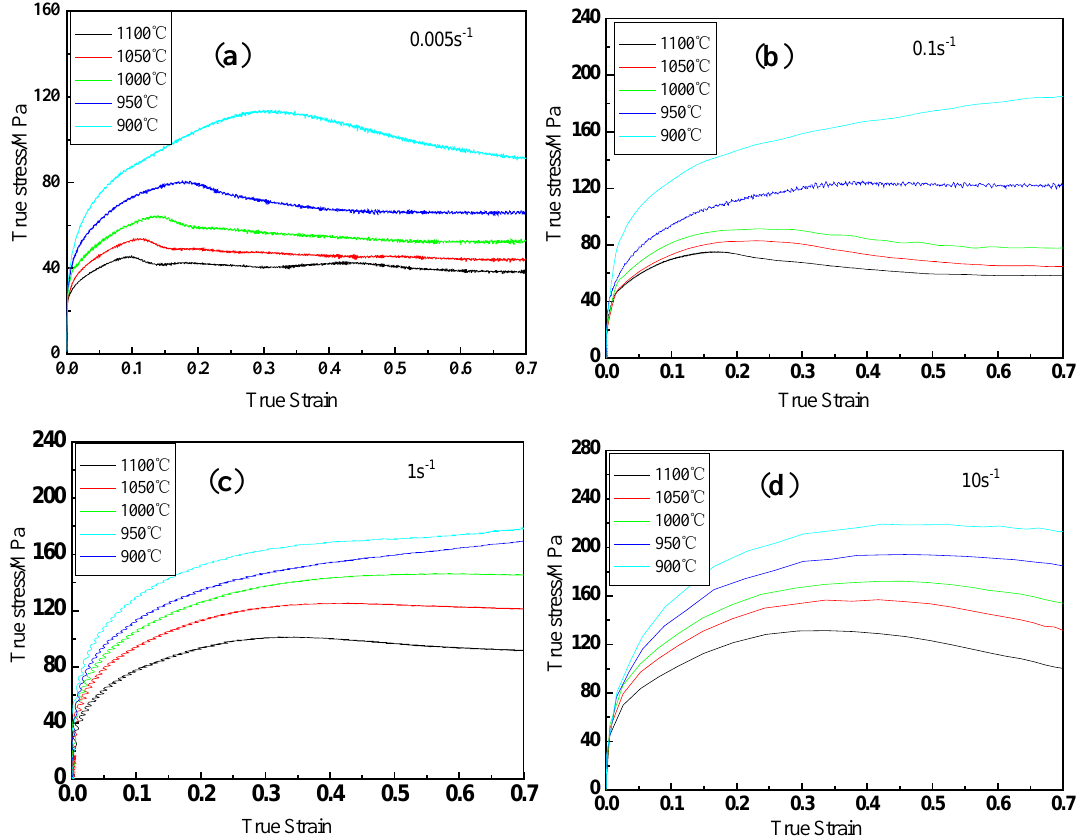
Figure 1. Flow curves of the examined steel at different temperatures and strain rates of ( a ) 0.005 s − 1 , ( b ) 0.1 s − 1 , ( c ) 1 s − 1 and ( d ) 10 s − 1 .